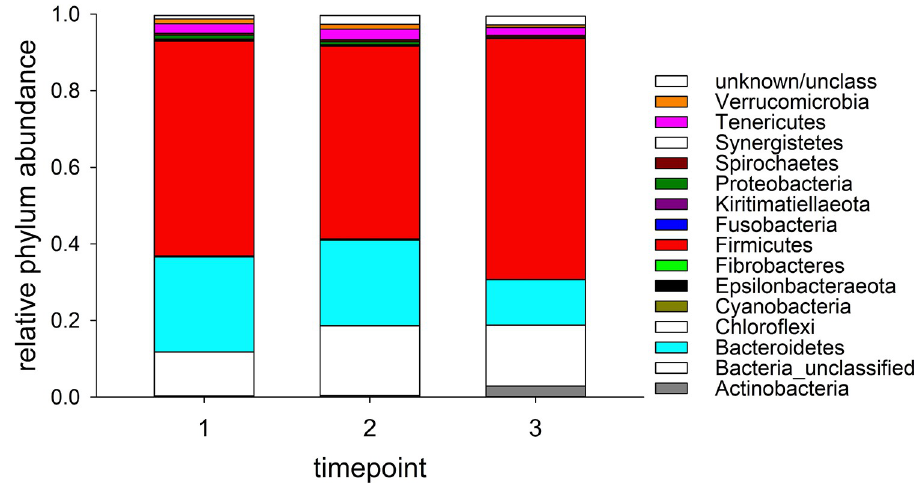
Fig 1. Classification of alpaca fecal microbiota 16S sequences reveals a high relative abundance of Firmicutes. The analysis is based on 258,889 unique curated 250-nt sequences, used the method of Wang [30] and has a confidence threshold of 75%.